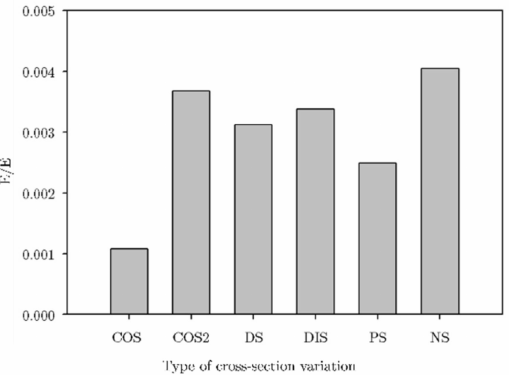
Figure 10. Normalized apparent Young’s modulus of uniformly periodic lattice structures via